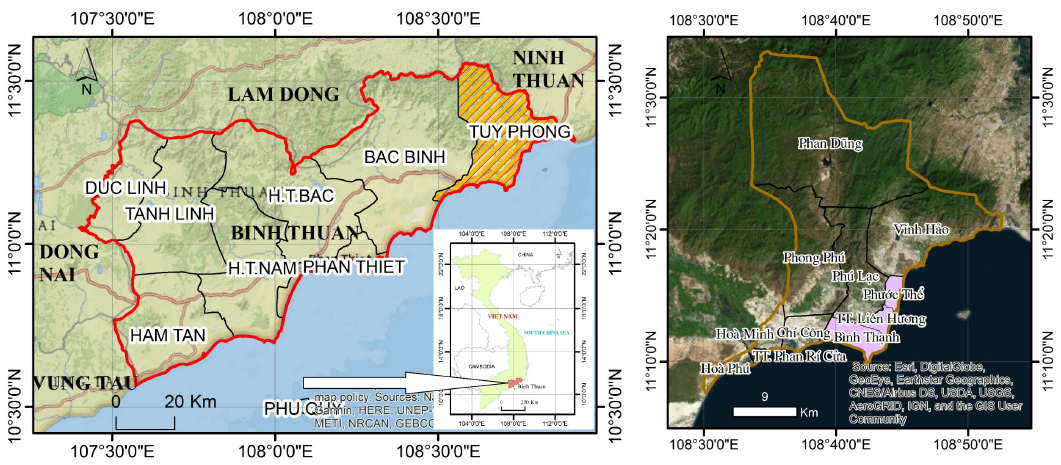
Figure 1. The case study is covering three coastal communities Binh Thanh, Lien Huong, and Phuoc The of Tuy Phong District which are highlighted in pink on the right map.